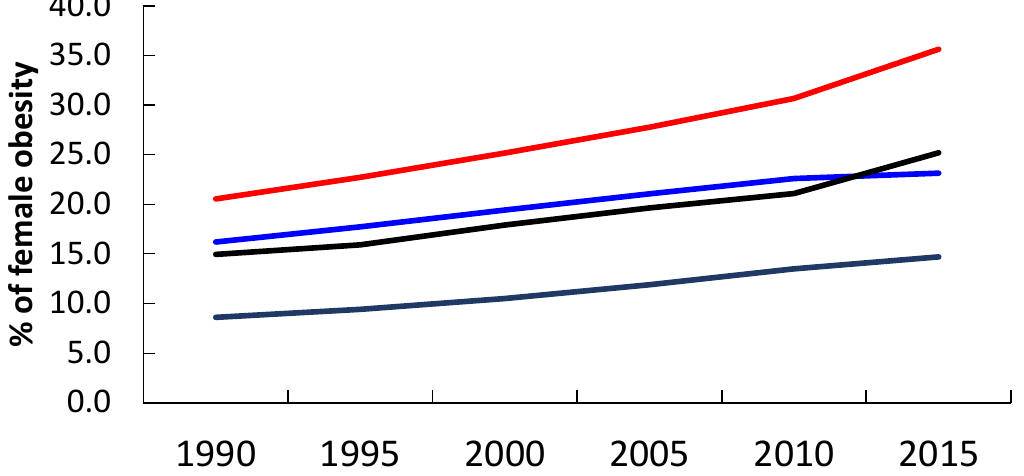
Figure 2. Percent of female obesity (BMI >30 kg/m 2 ) in Mediterranean country groups, 1990–2015, compared to world trends. Key (from top to bottom): Red line North African and Eastern Mediterranean countries; Blue line High Income countries; Black line Eastern Europe LMIC; Grey line World. (Source reference 16 from WHO